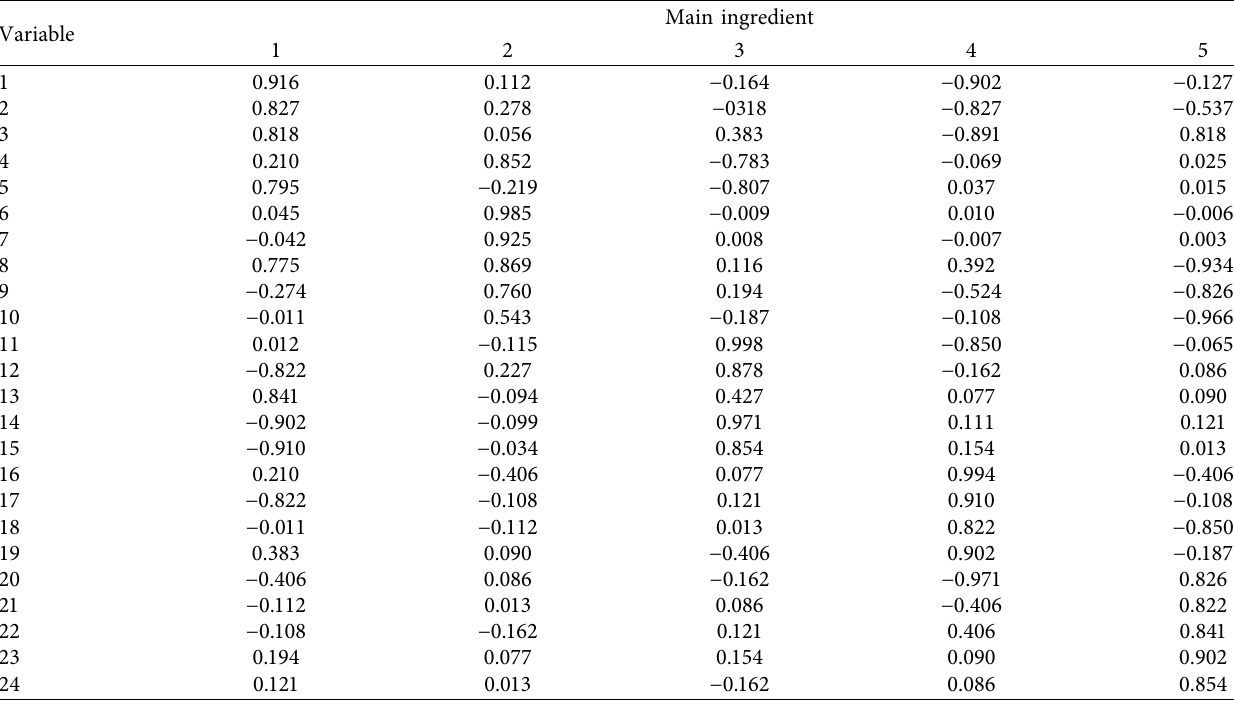
Table 5: Rotation component